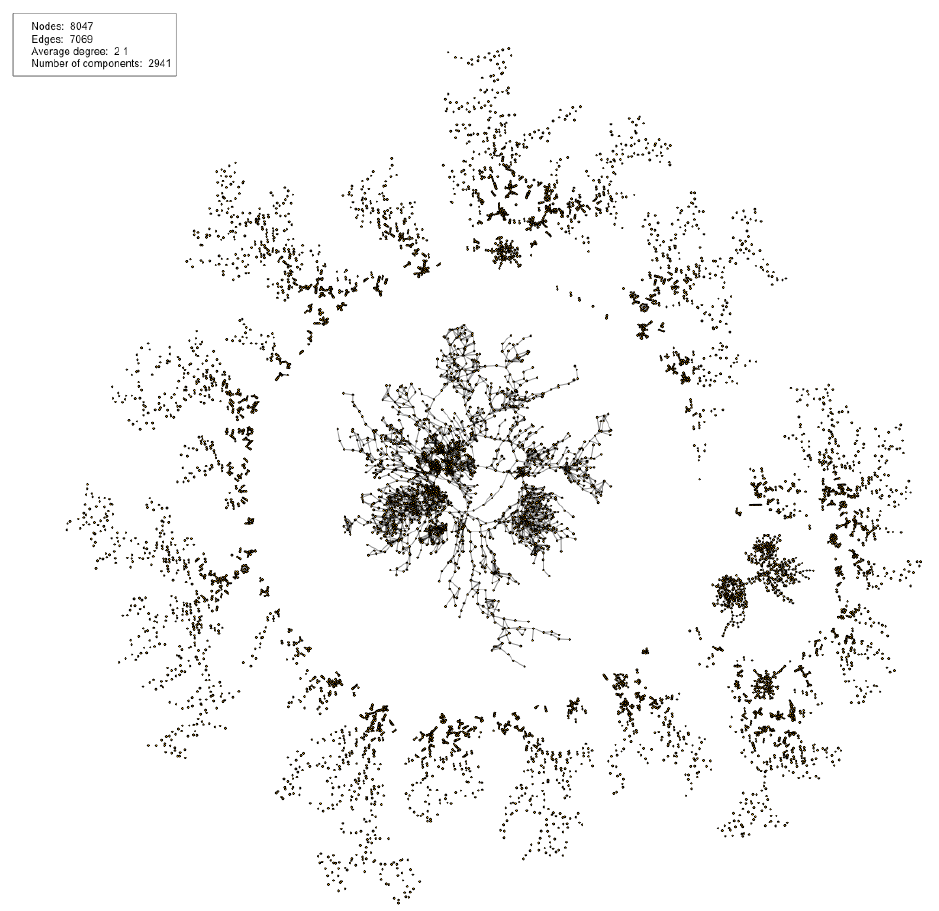
Figure 16. Channel network for